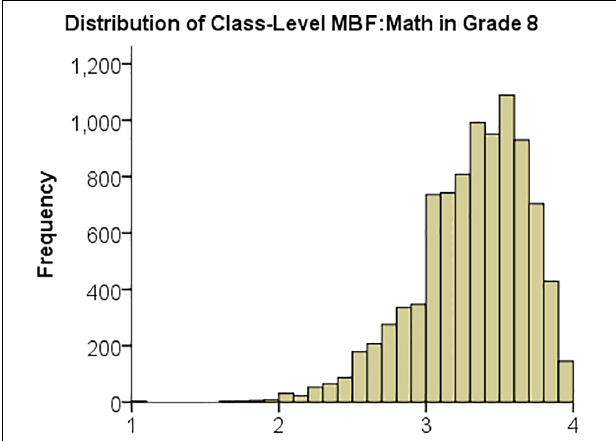
FIGURE 1 | Histogram over MBF:Math, the class-level measure of mistake-based feedback in mathematics, of all classes in 8th grade.